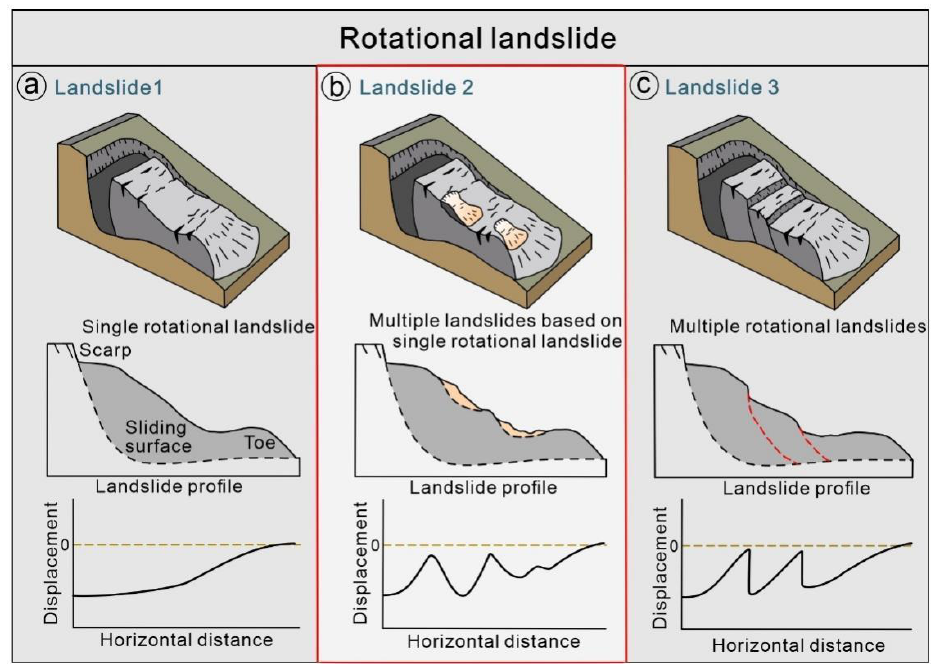
Figure 11. Displacement patterns compared with other two similar rotational landslides (adapted from Frattini et al. [8]). ( a ) Single rotational landslide. ( b ) Multiple landslides from Lianluo land- slide. ( c ) Multiple rotational landslides. ( c ) Multiple rotational